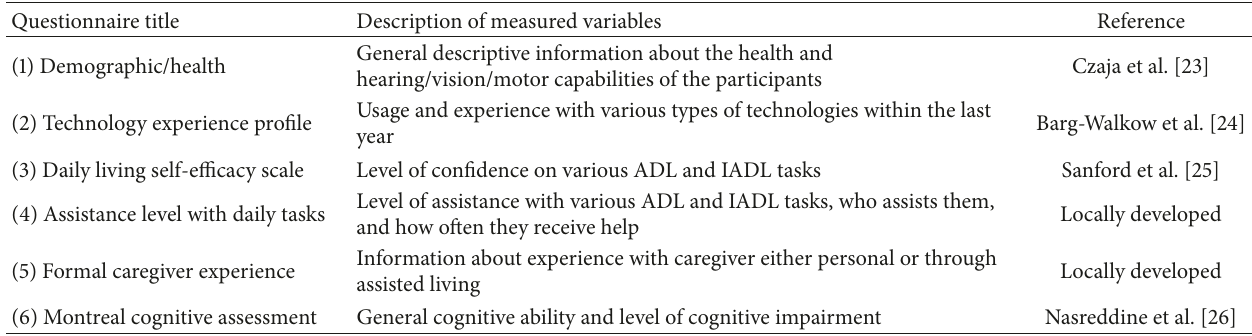
Table 2: Preinterview